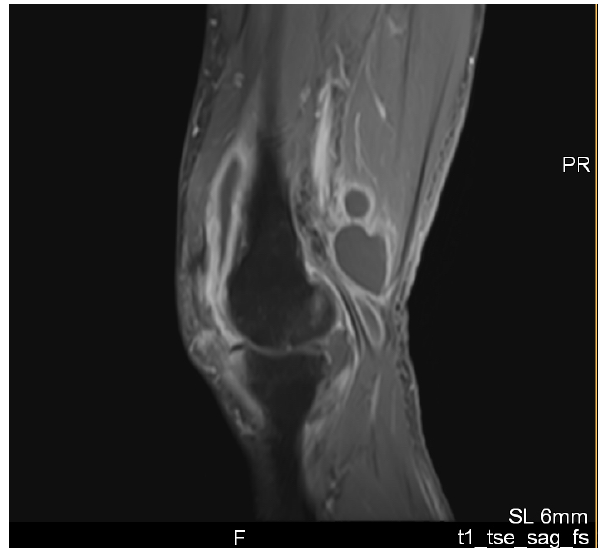
Figure 1. Sagittal MRI slice (T1 fat suppression) of the left knee showed massive synovitis where the thorn fragment was